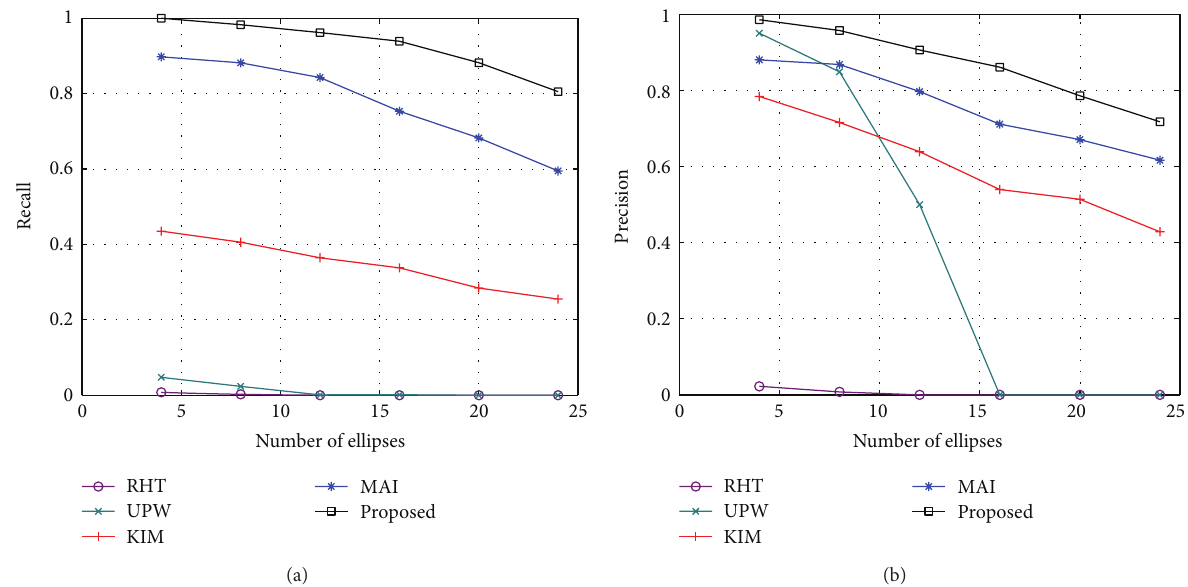
Figure 9: Recall and precision of each method for different number of ellipses. (a) Recall. (b) Precision.